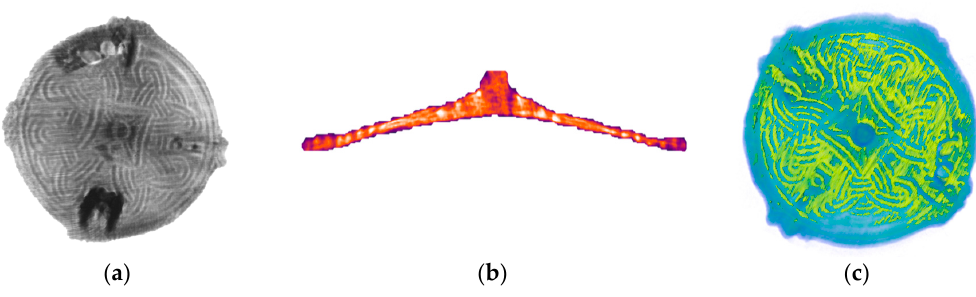
Figure 6. ( a ) The neutron radiography image of the fibulae. The bright regions correspond to high neutron attenuation in the golden component; the darker areas are the low neutron attenuation regions of copper. The parts of the remains of clasp on the reverse size of the fibulae are dark; ( b ) the axial tomography slice of the fibulae are presented as an example; the light areas correspond to gold inclusions, the orange regions are the copper body; ( c ) the virtual 3D model of the fibulae with separated golden ornament.